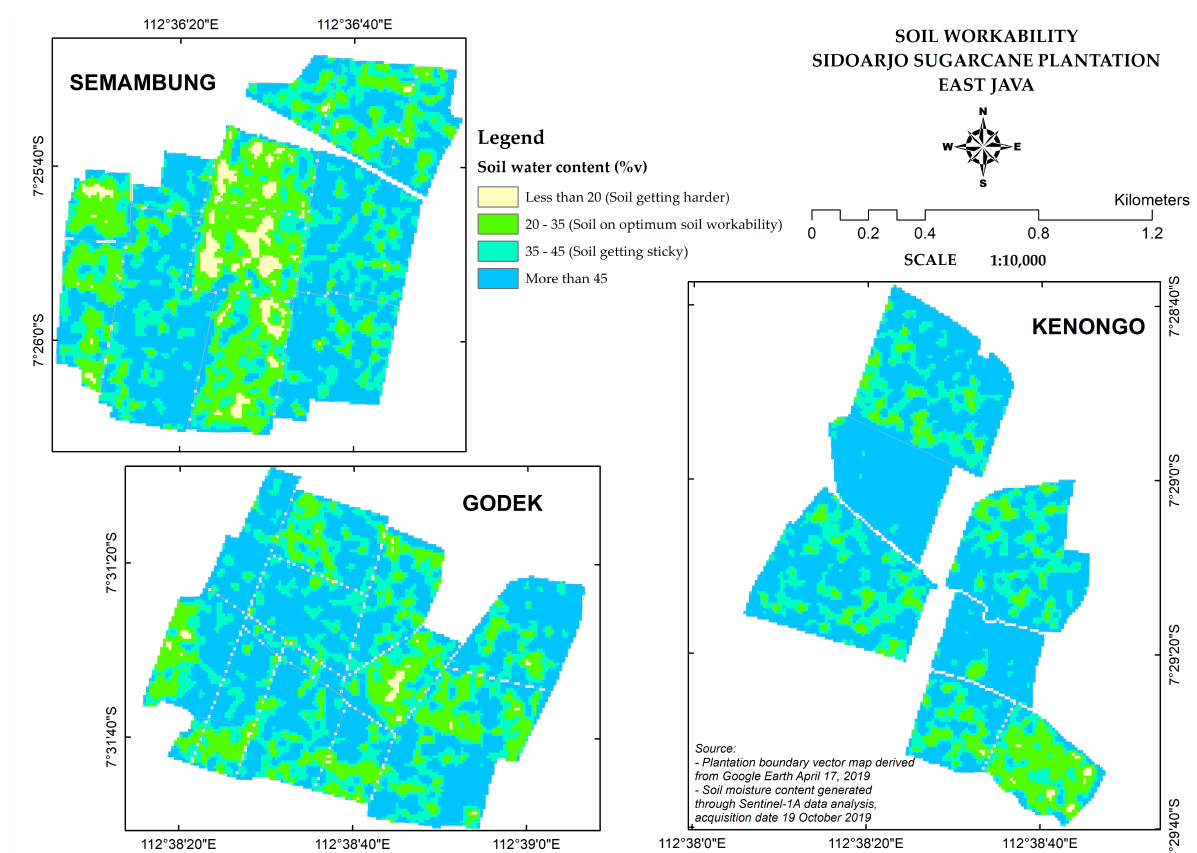
Figure 9. Spatial distribution of soil workability in Kediri ( left ) and Sidoarjo ( right ) plantations on 15 October 2019 and 19 October 2019,